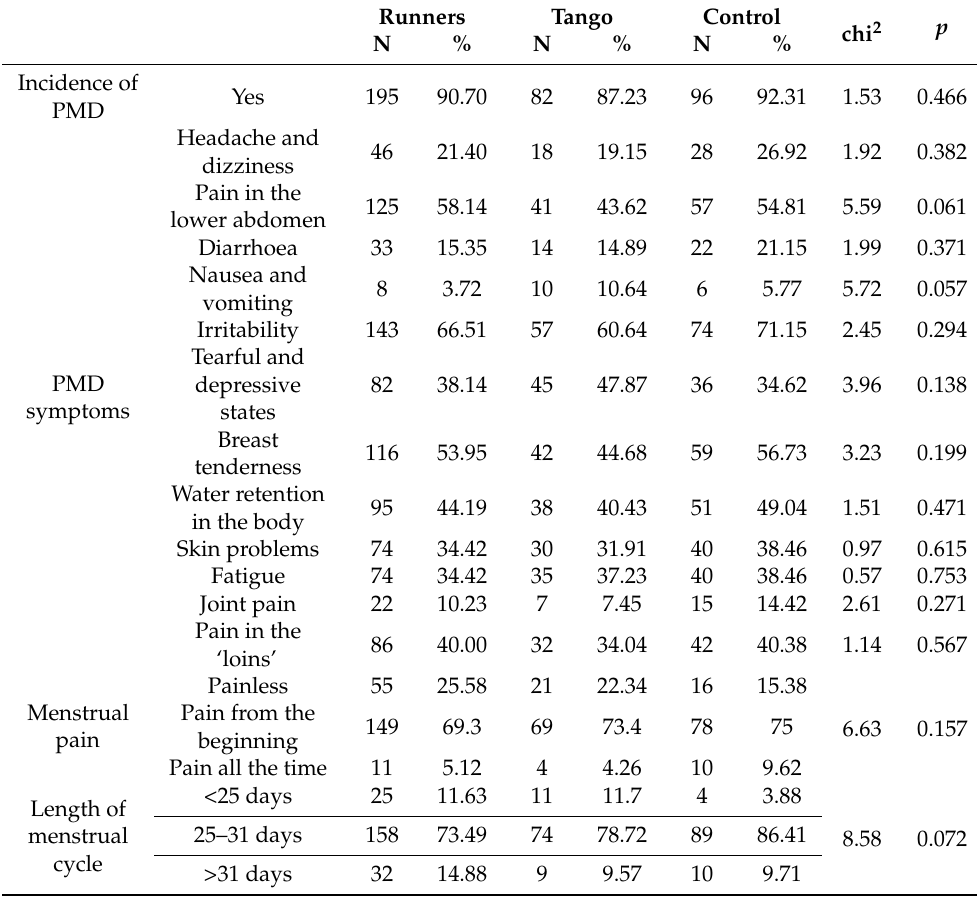
Table 3. Percentage of women in the runners ( N = 215), tango ( N = 94), and control ( N = 104) groups experiencing various symptoms of PMD and pain at different times of menstruation and the duration of their menstrual